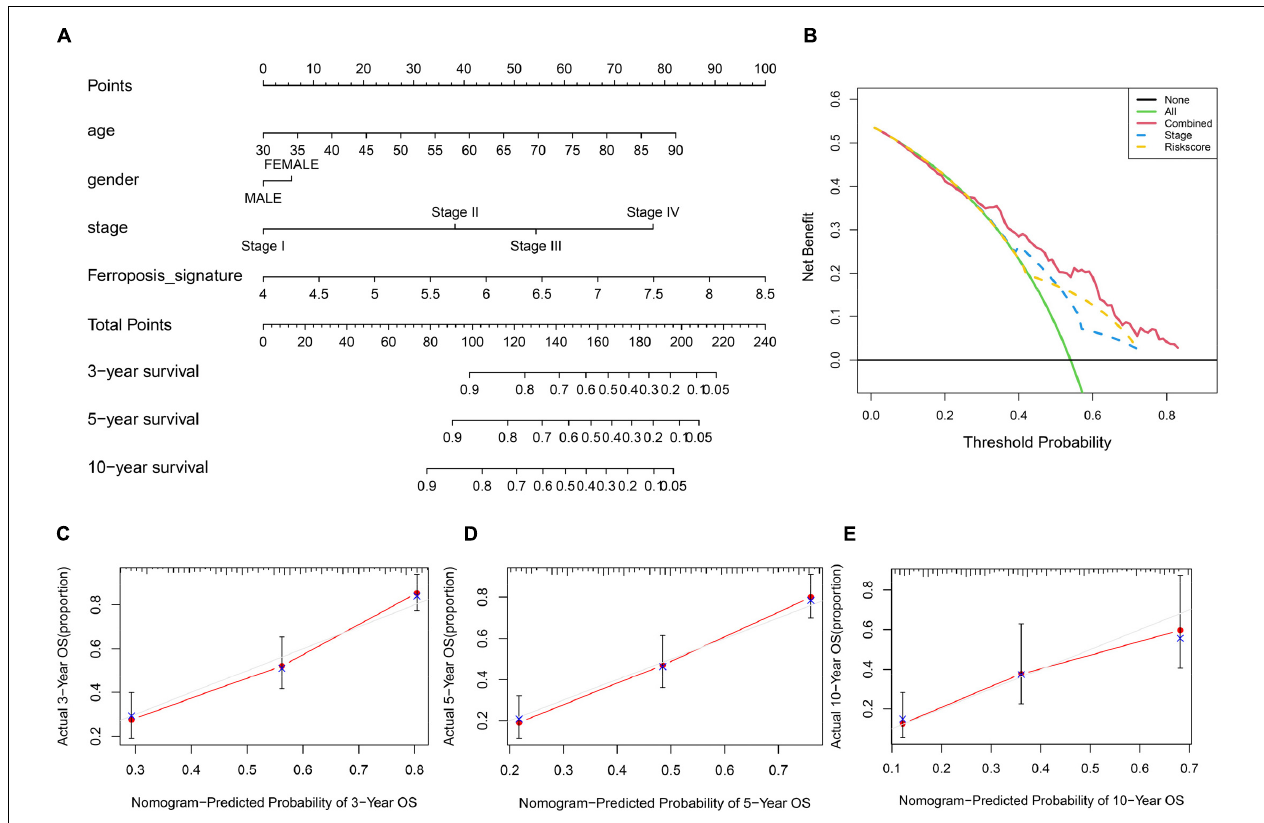
FIGURE 5 | Construction and validation of a nomogram. (A) Prognostic nomogram predicting overall survival probability of BC patients. (B) DCA curves analysis for the nomogram. (C–E) Calibration curves of the nomogram for predicting overall survival